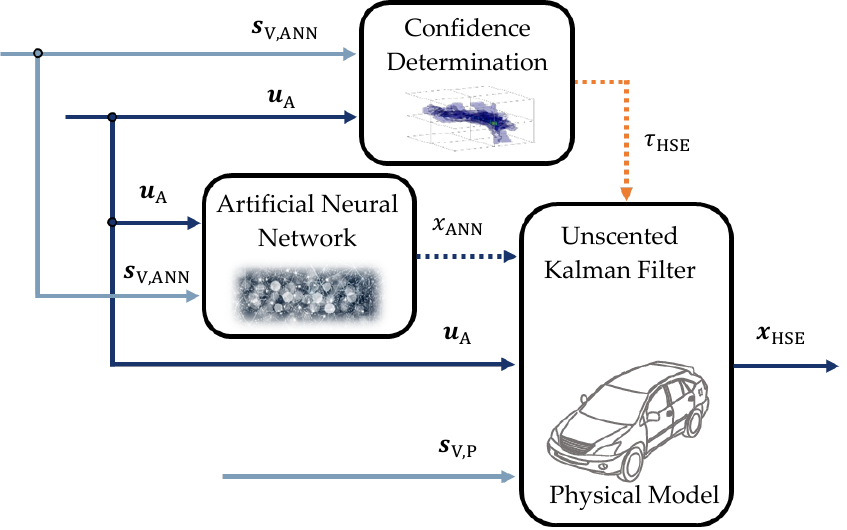
Figure 2. Hybrid Method of State Estimation—Structure, according to